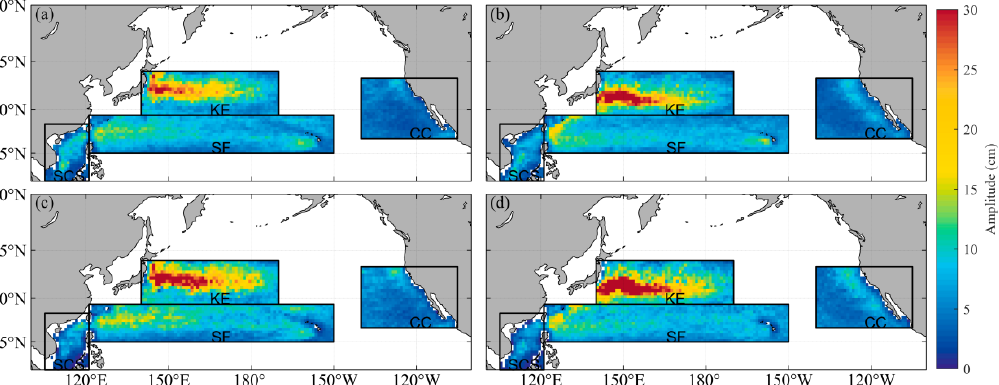
Figure 12. Same as Figure 9, but for eddy amplitude. Figure 12. Distribution of eddy amplitude. AEs and CEs detected by the META dataset are given in ( a ) and ( b ), respectively. Identically, AEs and CEs detected by the GOMEAD dataset are given in ( c ) and ( d ),